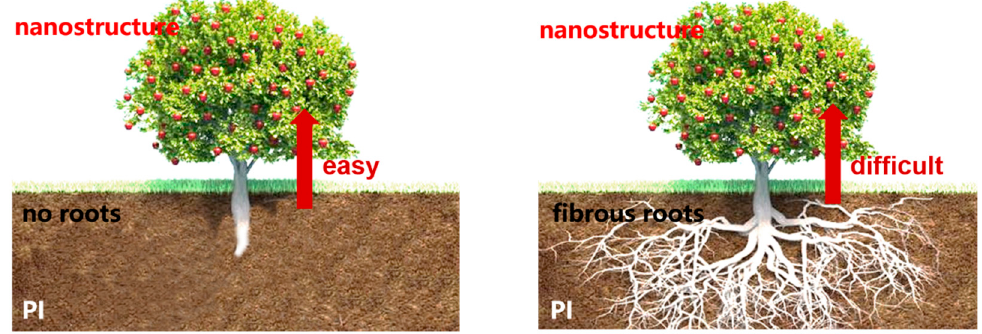
Figure 9. Schematic diagram of strong adhesion of in situ methods.